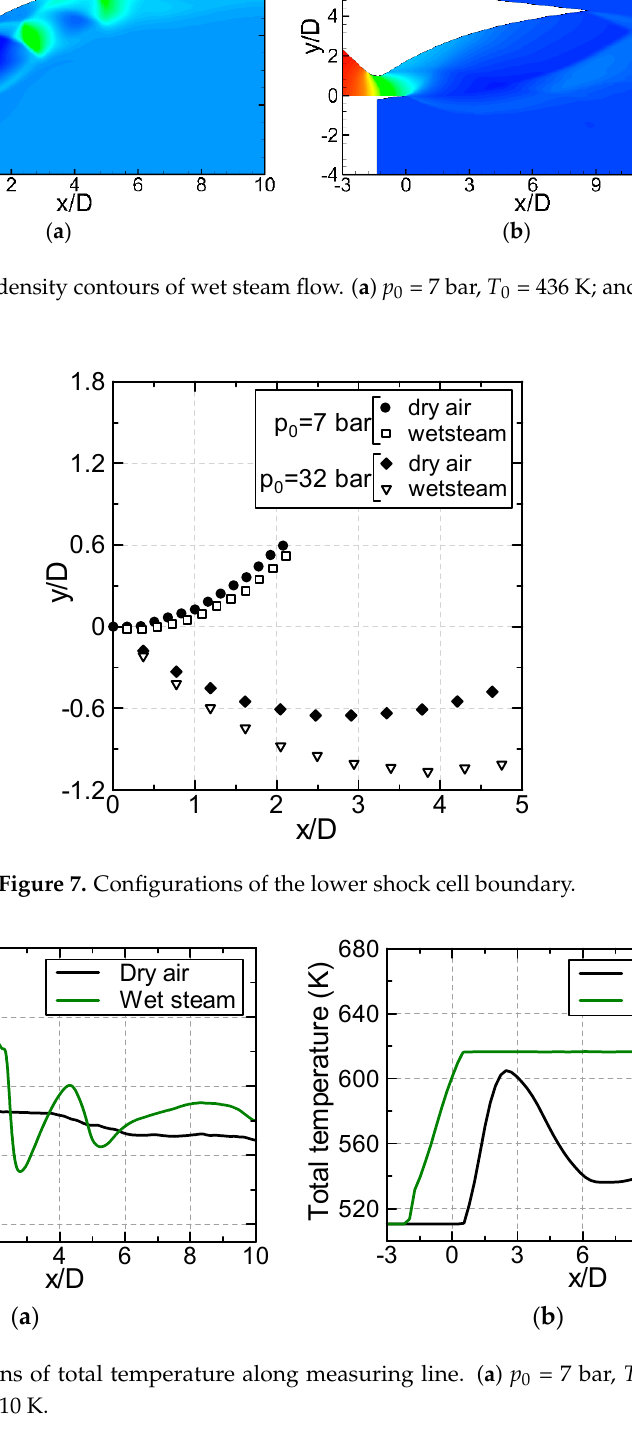
Figure 8. Distributions of total temperature along measuring line. ( a ) p 0 = 7 bar, T 0 = 436 K; and ( b ) p 0 = 32 bar, T 0 = 510 K.